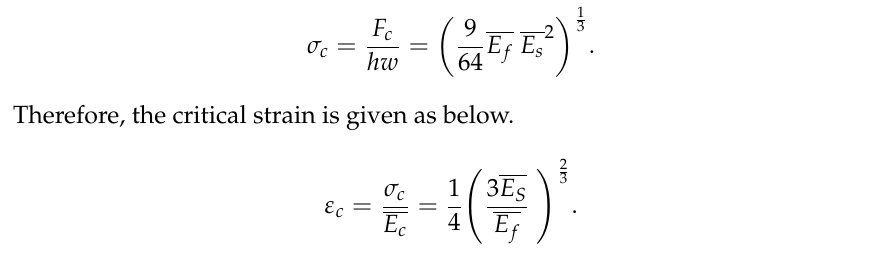
Figure 2. Buckled thin fi lm due to applied strain.